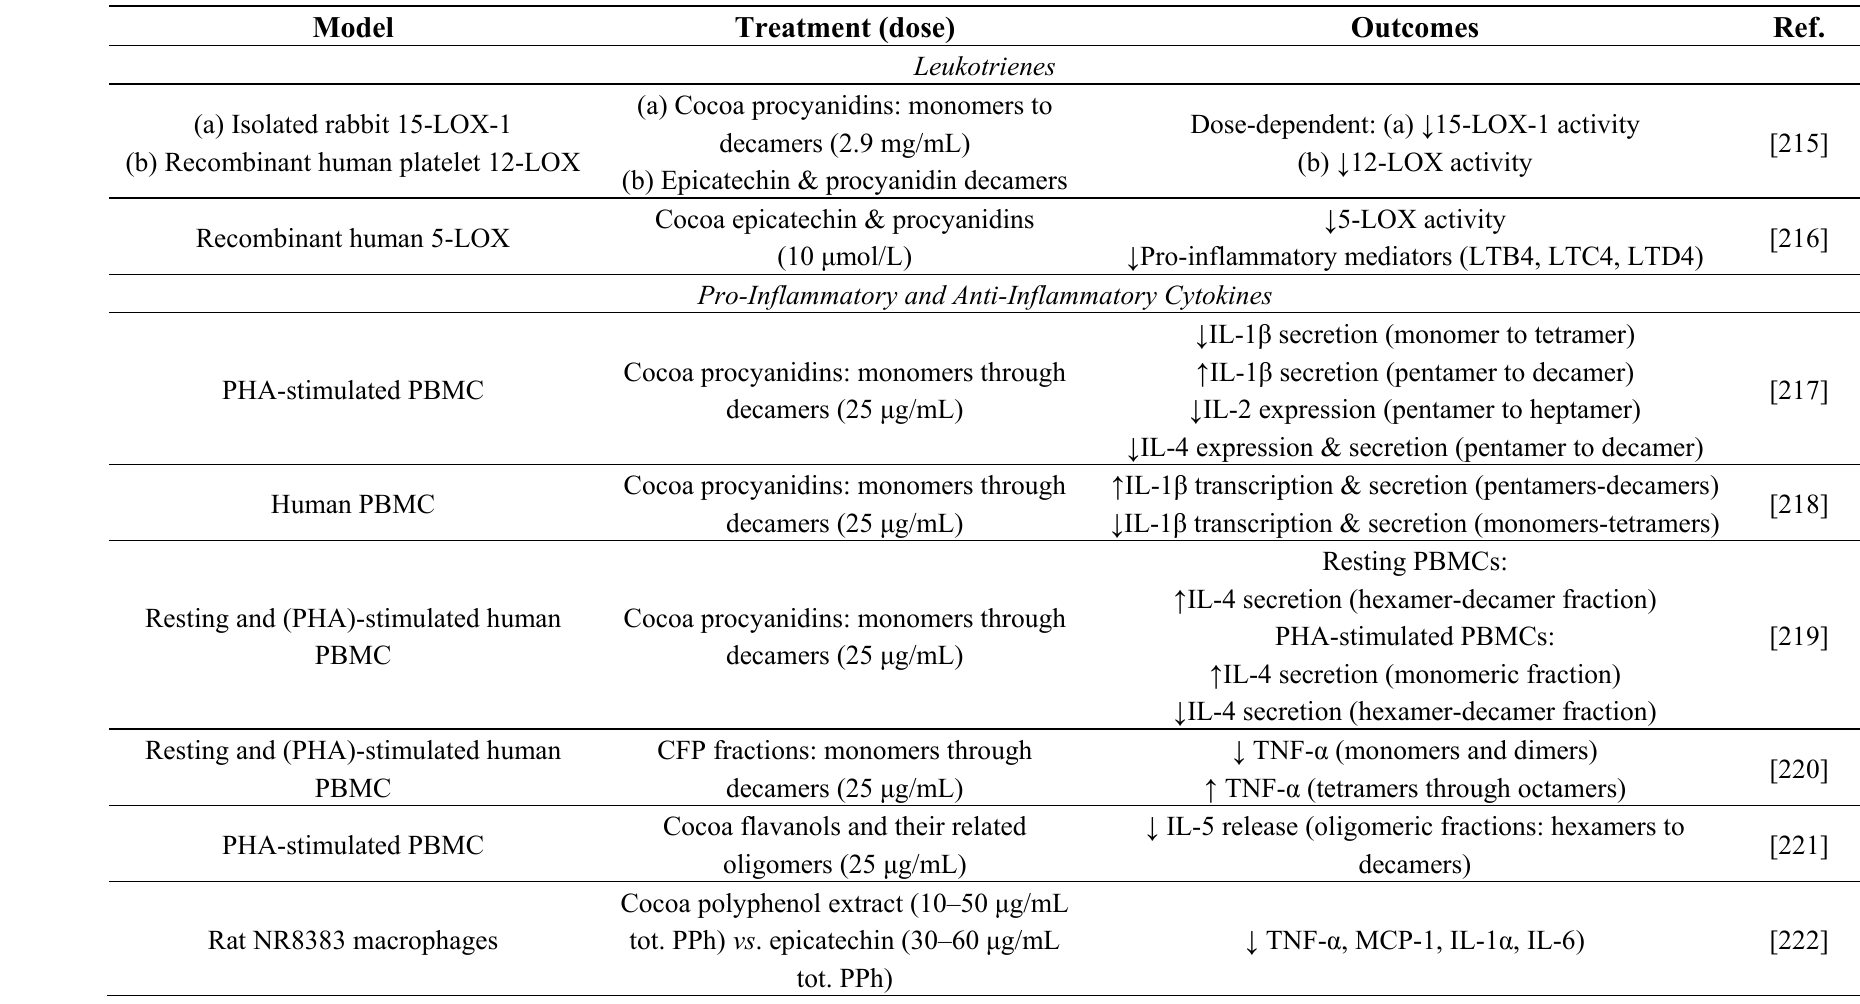
Table 2. In vitro studies on cocoa polyphenol CVD-related anti-inflammatory activities. Ref. =